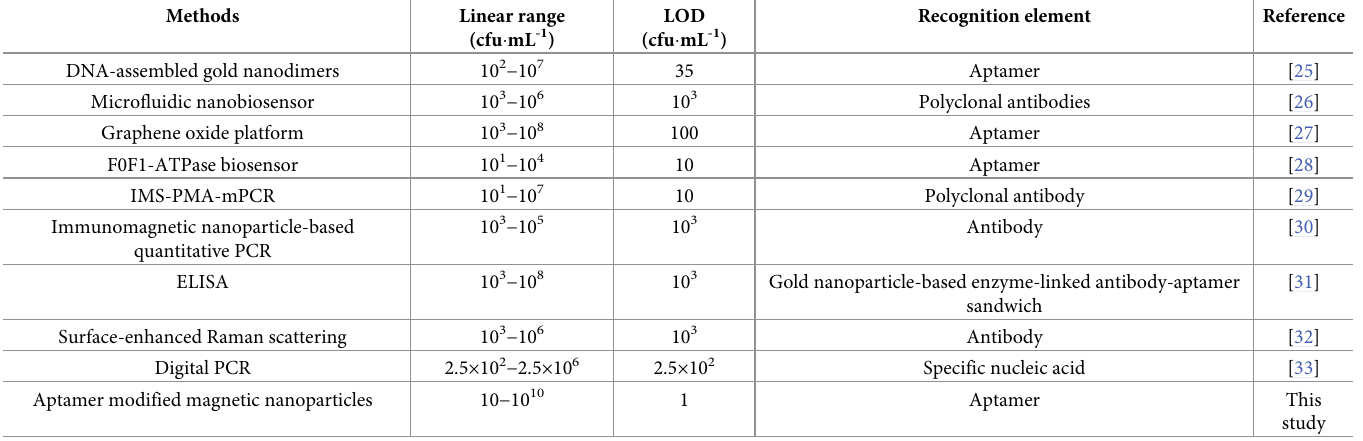
Table 1. Comparison of different methods for the detection of S . Typhimurium .